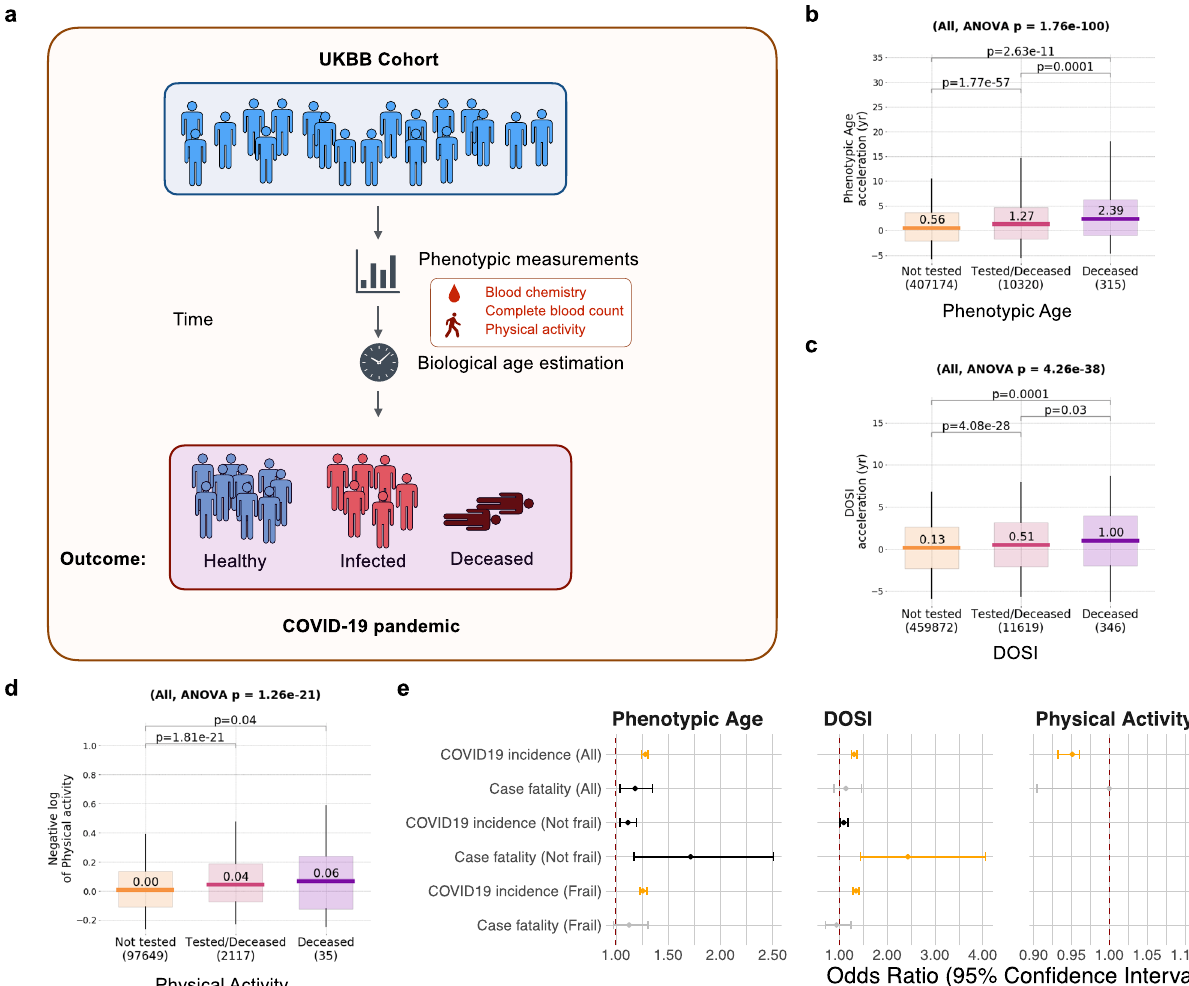
Fig. 2 Analysis of association of biological age acceleration with the risk of COVID-19. a Schematic representation of analysis of the biological age acceleration in the UKBB cohort. The box plots showing the distribution of biological age acceleration measured by phenotypic age ( b ), DOSI ( c ), and negative log physical activity ( d ) in UKBB subjects that were not tested, tested, or died with COVID-19 infection. Boxes indicate 25 − 75% interquartile ranges, and whiskers indicate minimum to maximum. The sample size ( N ) for each group is shown under the x -axis. e The forest plot is showing the predicted effect of biological age acceleration on the risk of COVID-19 in different categories. Error bars show the 95% con fi dential interval. Signi fi cant effects ( P < 0.001) are in orange. Nominally signi fi cant effects ( P < 0.05) are in black. The odds ratio for Phenotypic Age and Dynamic Organism State Index (DOSI) is given per 10-yr biological age acceleration. The odds ratio for physical activity is given per increase of 1000 steps/day. UKBB UK Biobank, DOSI Dynamic Organism State Indicator. Table 2 Association between biological age acceleration and the risk of COVID-19.